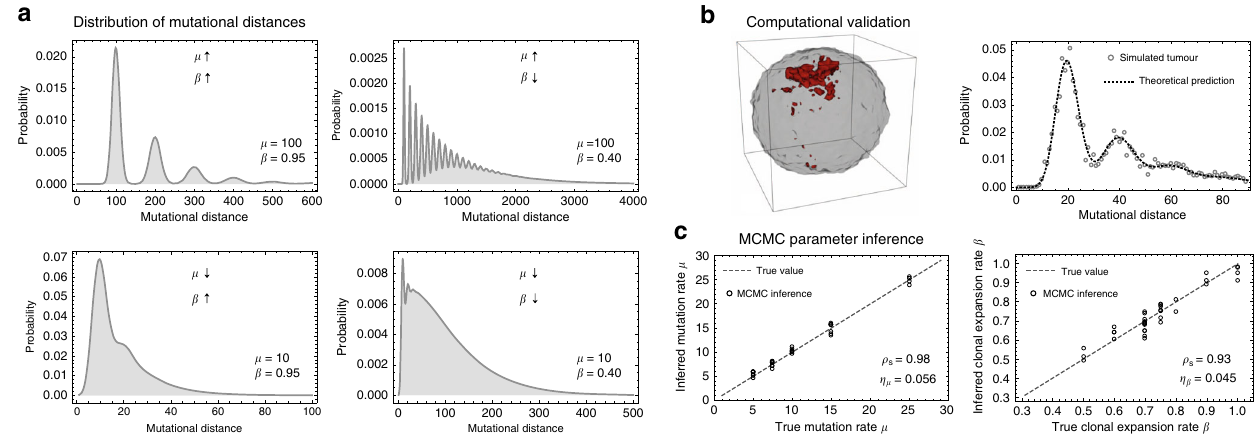
Fig. 2 Distribution of mutational distances and computational validation. a The quantised nature of cell divisions leads to a characteristic predicted distribution of mutational distances across cell lineages. The shape of the distribution depends on the exact values of μ and β . Roughly four different scenarios of combinations of small and large μ and β are possible. They in fl uence the shape of the distribution differently and thus constructing the distribution of mutational distances allows disentangling the mutation rate μ and cell survival rate β . b Spatial stochastic simulations con fi rm the ability of mutational distance distributions to disentangle mutation and lineage expansion rates (red area shows the spatial spread of a subclonal mutation). Dots show mutational distances inferred from 200 samples of a single stochastic computer simulation ( μ = 20, β = 0.95), the dashed line is the predicted distribution based on our Eq.(7). c A Monte Carlo Markov Chain inference framework based on mutational distance distributions reliably identi fi es mutation and lineage expansion rates in simulations of spatial and stochastically growing tissues (two-dimensional spatial stochastic simulations, μ : Spearman Rho = 0.98, p = 4 × 10 – 23 ; β : Spearman Rho = 0.93, p = 8 × 10 – 16 , Relative error: η μ = 0.056, η β = 0.045).